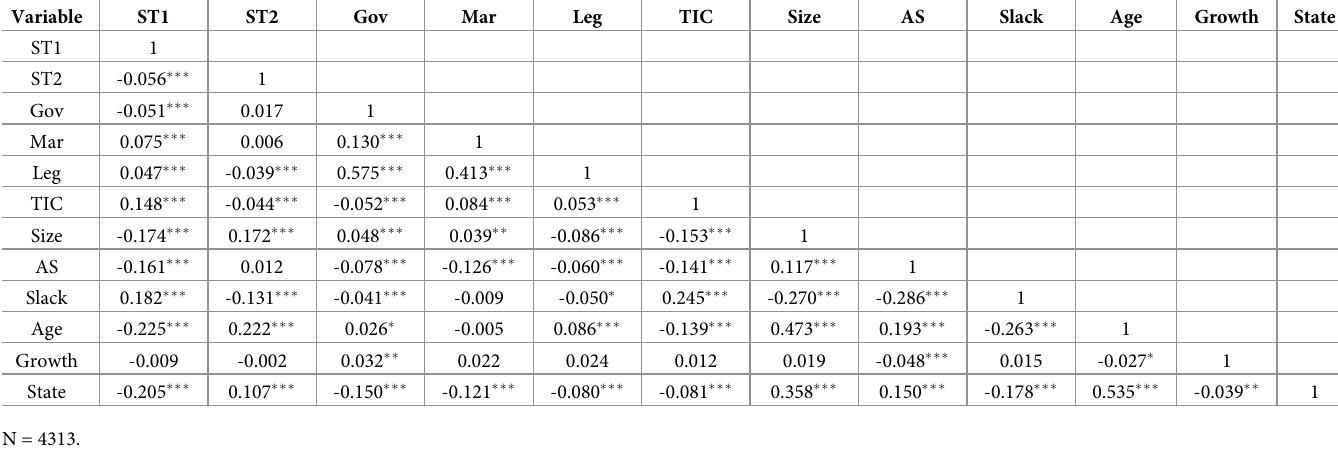
Table 3. Correlation analysis.